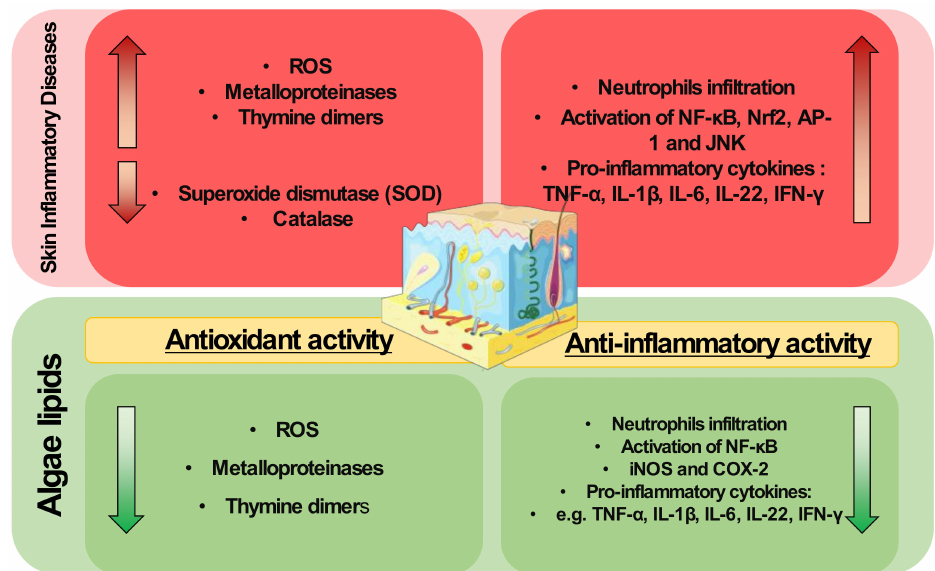
Figure 1. Algae lipids can target mediators responsible for the onset and progression of skin inflam- matory